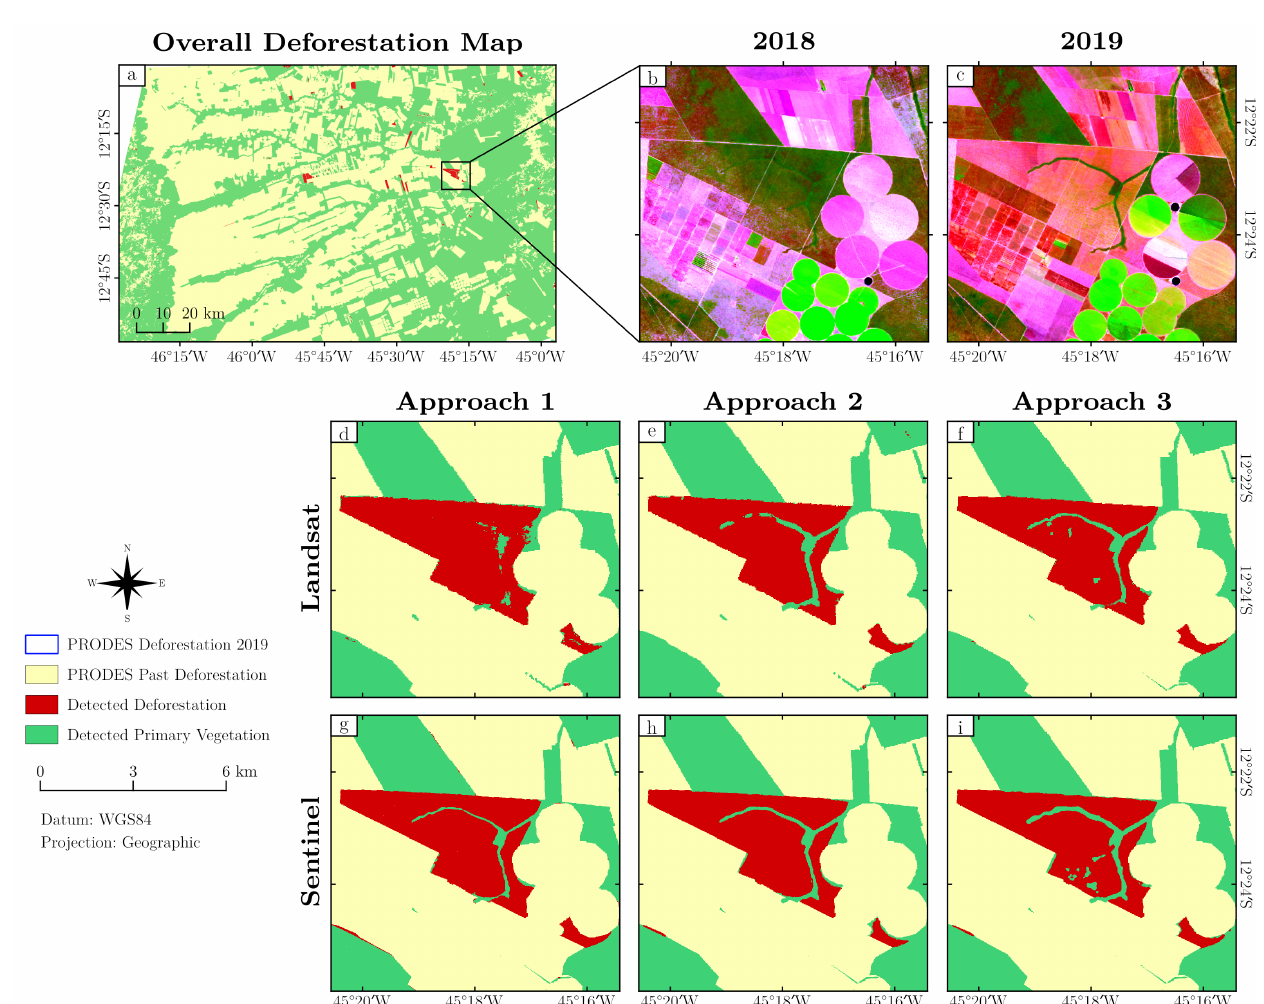
Figure 9. Results obtained for the largest deforestation polygon in the Bahia study area. ( a ) Deforestation map by PRODES for 2019 for the ‘main’ study area in Bahia. ( b , c ) RGB (Band 11, Band 8, Band 4) Sentinel-2/MSI images for 4 July 2018 and 4 July 2019, respec- tively, overlaid by the largest PRODES deforestation polygon for the Bahia study area in 2019; ( d , e , f ) Results using Landsat-8/OLI time series for Approaches 1, 2, and 3, respectively; ( g , h , i ) Results using Sentinel-2/MSI time series for Approaches 1, 2, and 3,